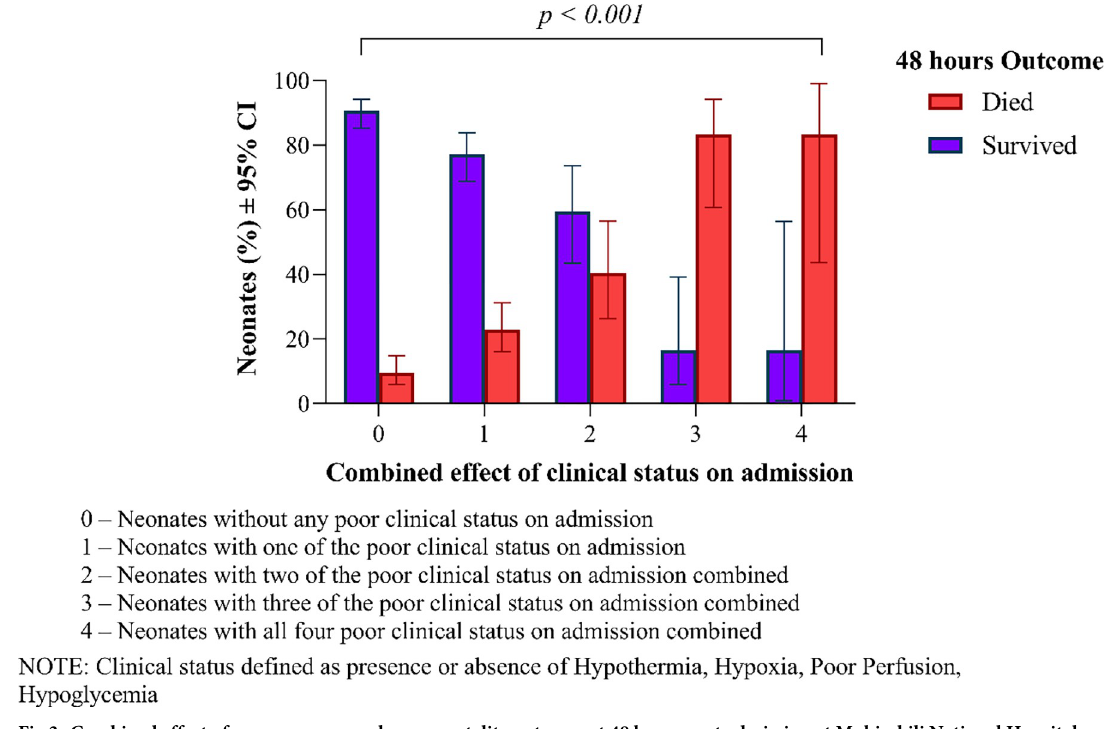
Fig 3. Combined effect of exposures on newborns mortality outcome at 48 hours post admission at Muhimbili National